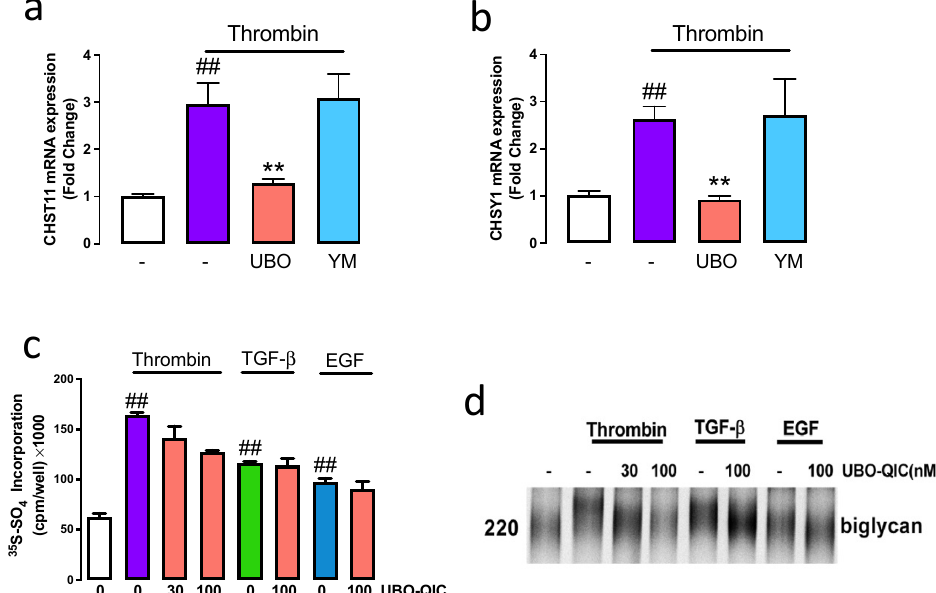
Figure 2. G α q is involved in PAR-1 regulation of mRNA expression CHST11 and CHSY1, proteo- glycan synthesis and GAG chain elongation. VSMCs were pre-incubated with UBO-QIC (UBO), or YM254890 (YM), for 30 min and then exposed to thrombin for 6 h. The mRNA expression of ( a ) CHST11 and ( b ) CHSY1 were assessed using RT-PCR. VSMCs were pre-incubated with UBO-QIC in the presence and absence of thrombin, TGF- β or EGF for 24 h with [ 35 S]-sulphate (50 μ Ci/mL). ( c ) Medium containing secreted proteoglycans were harvested and spotted onto 3 MM paper and were quantitated by CPC precipitation. The histogram shows the fold-change compared to the basal. ( d ) Secreted proteoglycans were isolated using ion exchange chromatography and electrophoresed on a 4–13% SDS-PAGE. Results are the mean and standard error from three separate experiments. Statistical significance analysis is represented with ##, p < 0.01 basal versus thrombin and **, p < 0.01 thrombin versus antagonists.